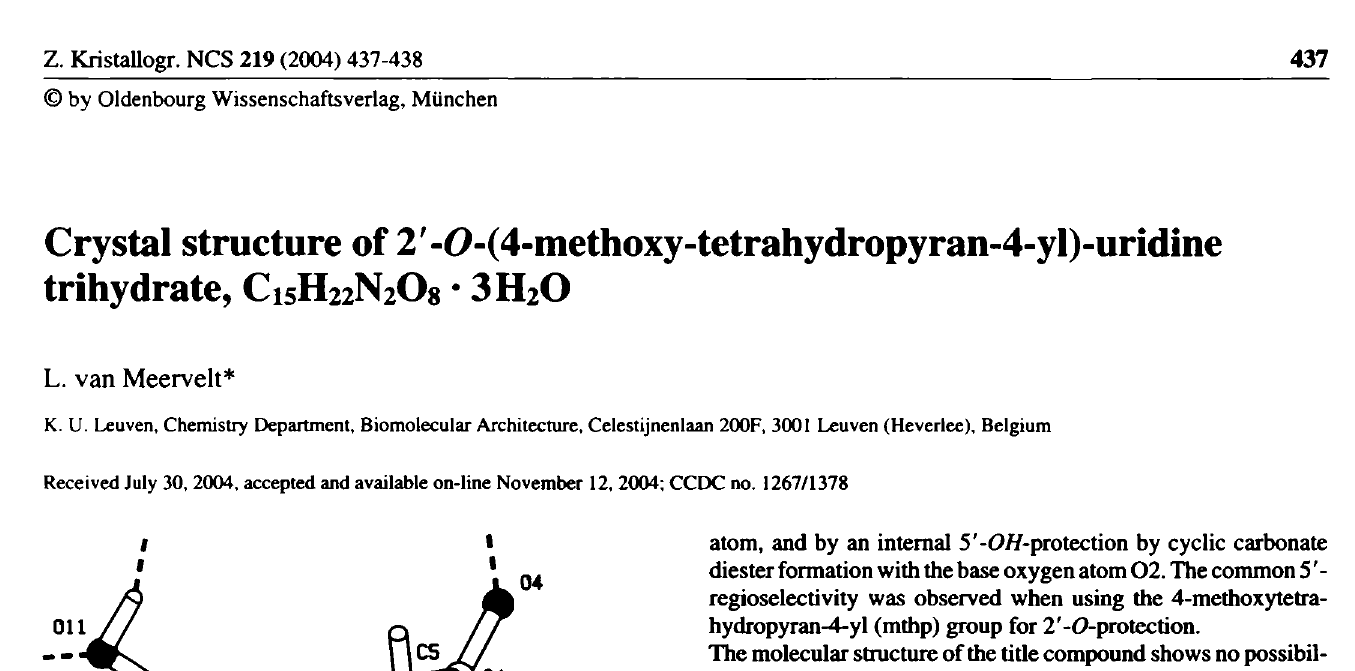
Table 1. Data collection and handling.